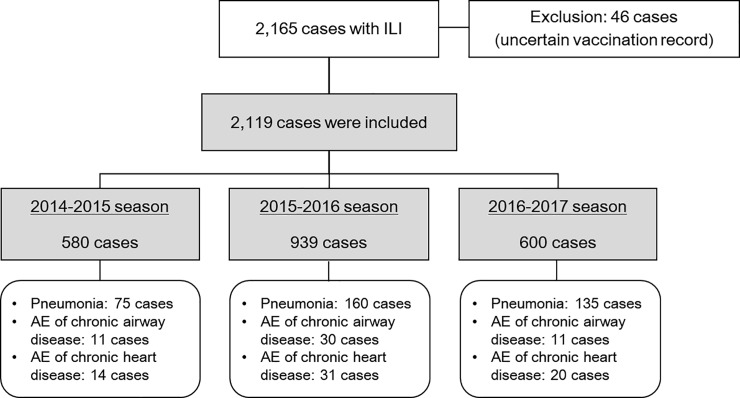
Study flowchart.